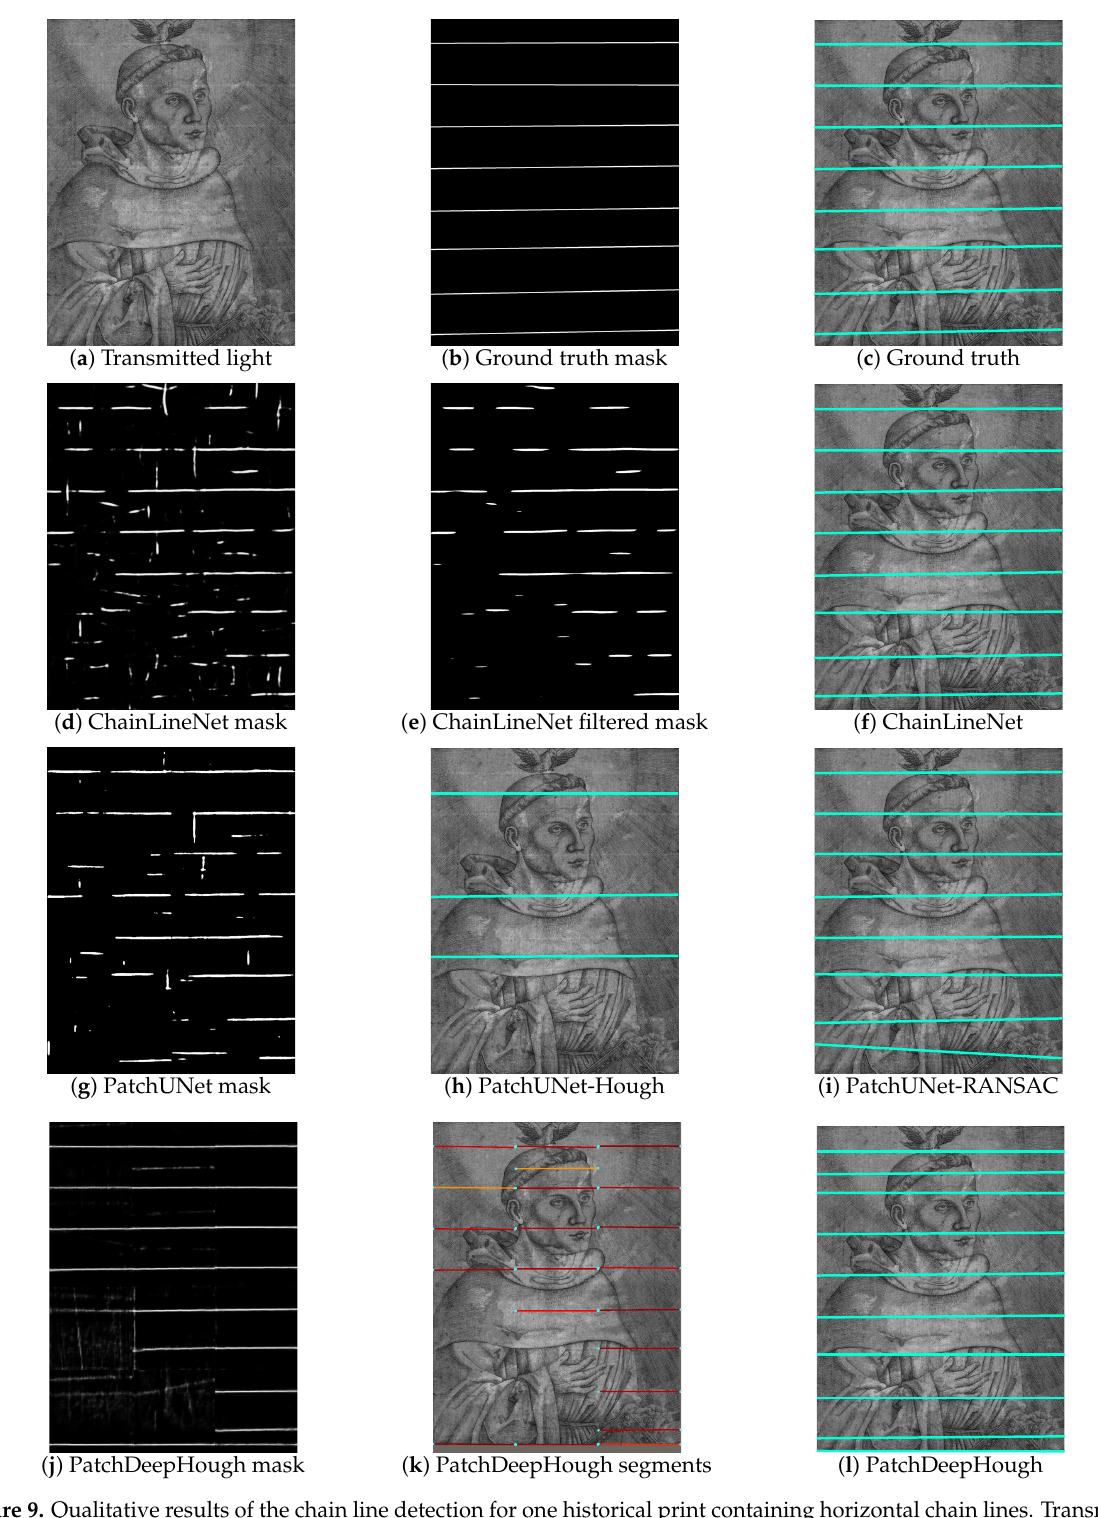
Figure 9. Qualitative results of the chain line detection for one historical print containing horizontal chain lines. Transmitted light image: Hieronymus Hopfer, Martin Luther as Augustinian monk with Holy Spirit as a dove , Etching, British Museum, London, 1845-0809-1486; Photo © Thomas Klinke, courtesy of the Trustees of the British Museum; all rights reserved by the respective